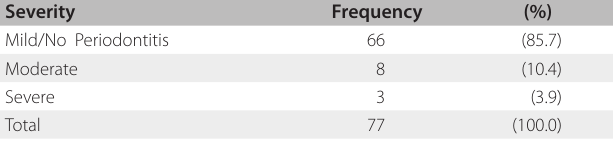
Table 6. Distribution of periodontal disease severity in control group Severity